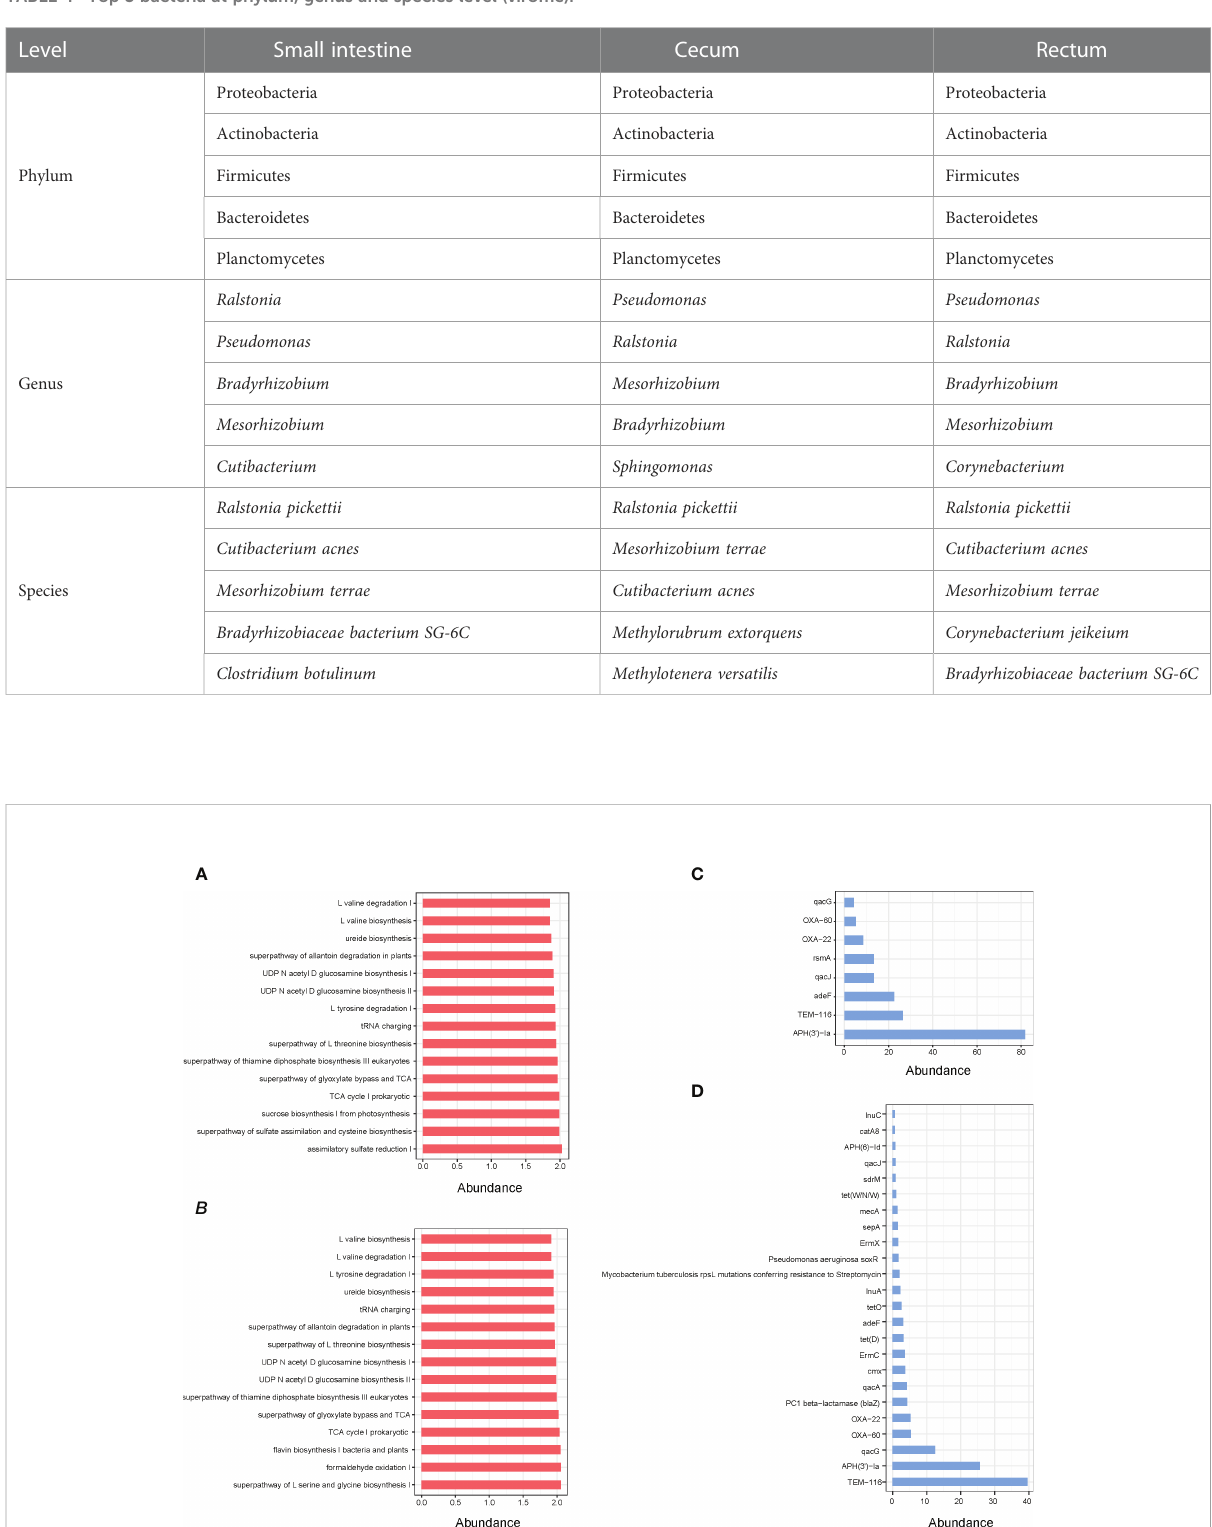
TABLE 4 Top 5 bacteria at phylum, genus and species level (virome).